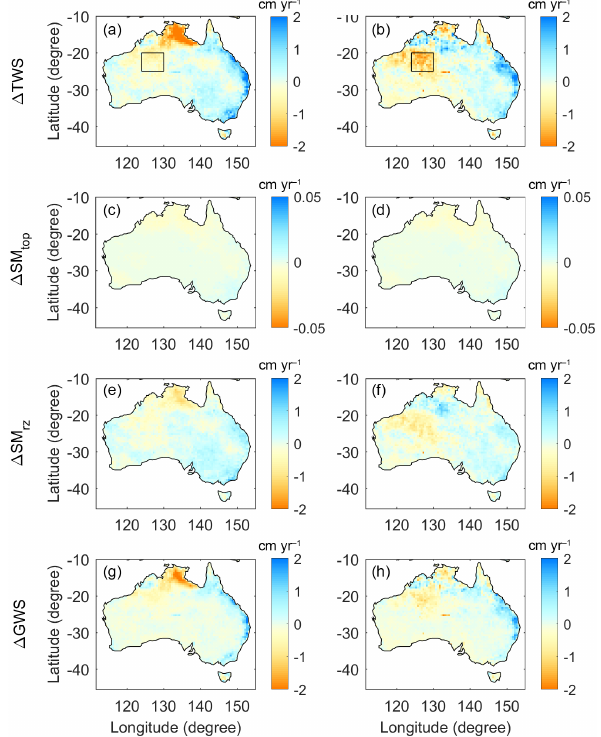
Figure 6. Long-term trends of (cid:49) TWS (a, b) , (cid:49) SM top (c, d) , (cid:49) SM rz (e, f) , and (cid:49) GWS (g, h) estimated from the model-only (left) and the GC solutions (right). The eastern part of North West Plateau basin is shown as a rectangle polygon in (a) and (b) .